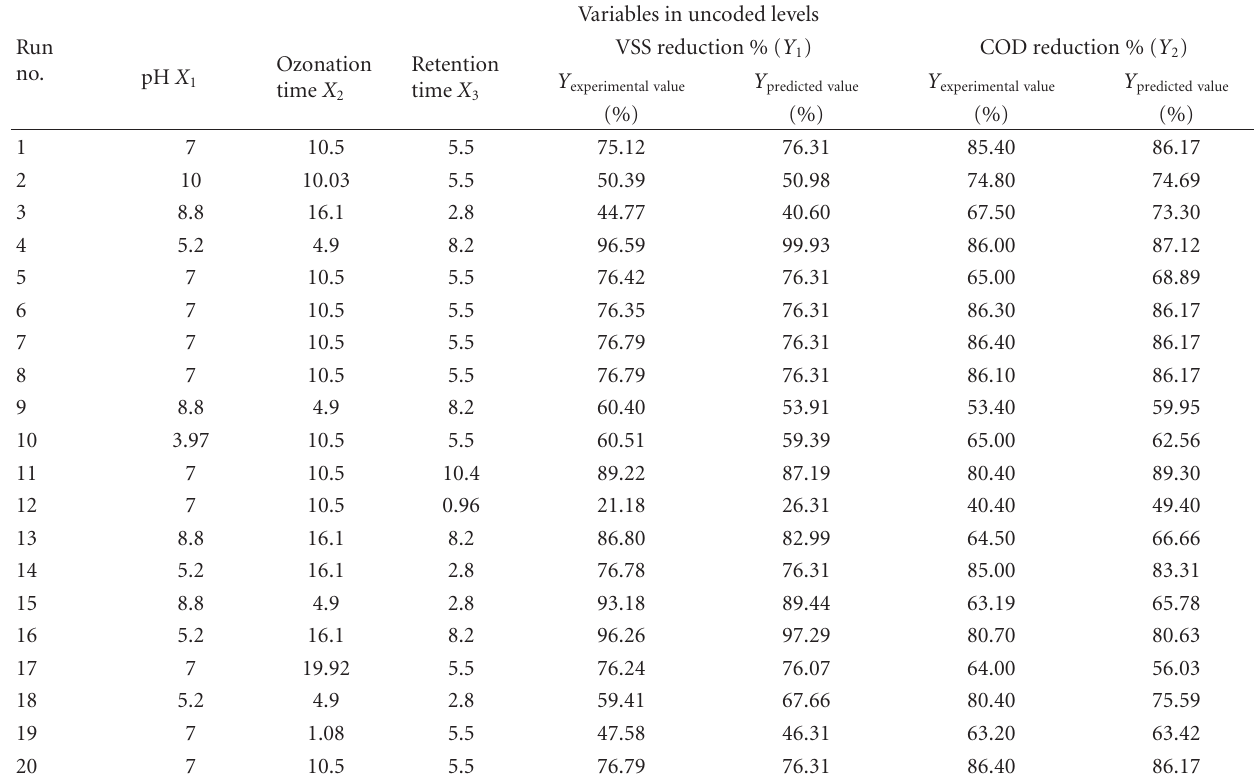
Table 3: The design matrix and observed values of the central composite